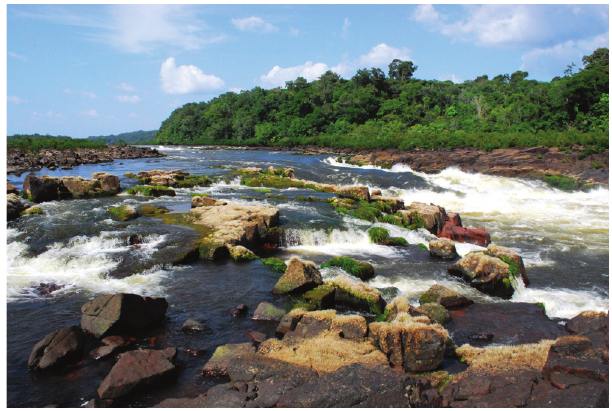
Fig. 5. Typical habitat of Tometes camunani , rapids and waterfalls in rio Trombetas basin, Pará, Brazil. Rocks are covered with Podostemaceae, rheophilic aquatic plants typical of the diet of species of Tometes (Photo by D. Bastos,